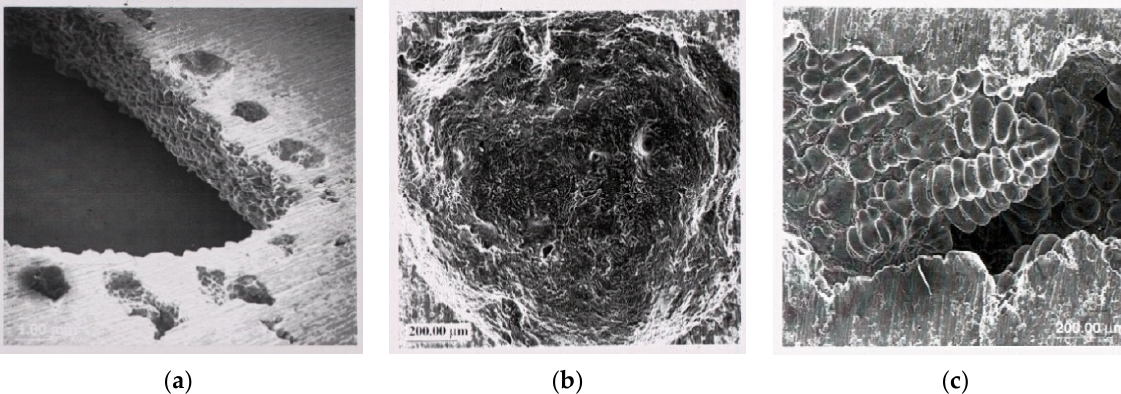
Figure 1. Hydrogen gas diffusing away from a core ( a ) precipitates early in ( b ), but delayed in ( c ) because of more difficult inflation of bifilm (Courtesy S. Fox 2000).